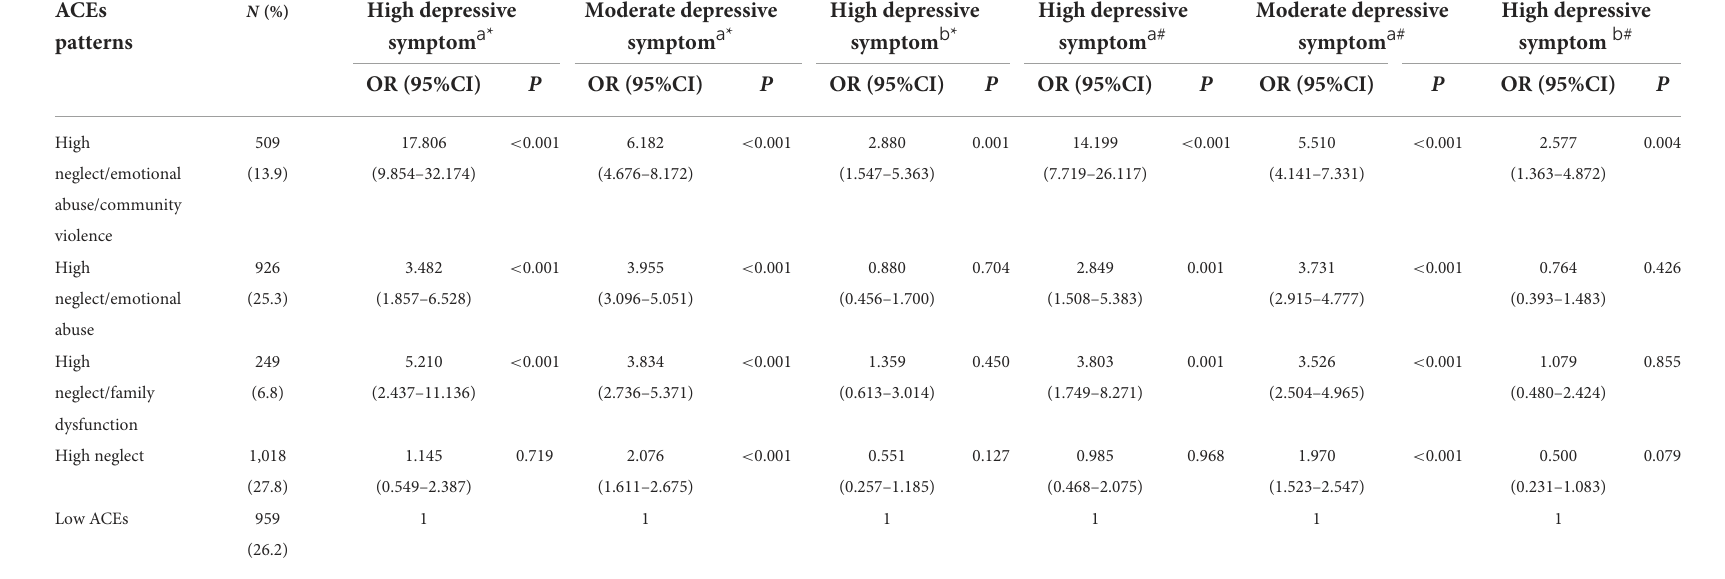
TABLE 3 Logistic regression models of depressive symptom trajectories by ACEs types and timing (Reference: Low